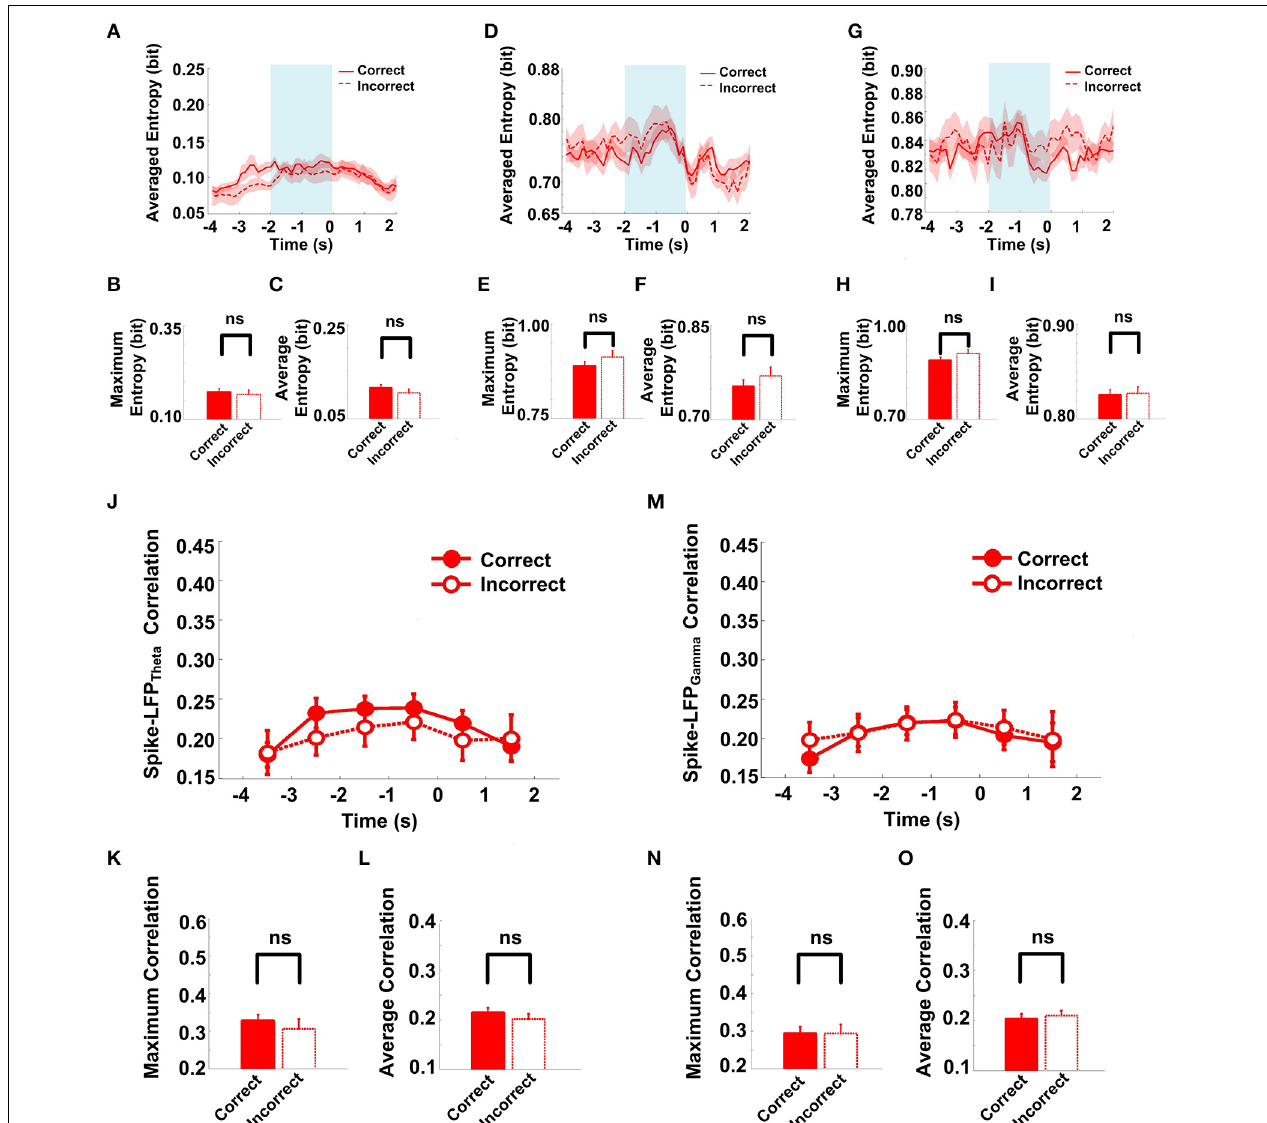
FIGURE 10 | Spike-LFP coordination in correct ( n = 35) and incorrect ( n = 21) trials in the A β group. (A) Averaged spikes entropy across correct (solid) and incorrect (dashed) trials. The shaded region indicates s.e.m. The light blue area indicates the period used for statistical analysis. Averaged entropy values were compared in this time window. (B) Peaks of spike entropy. (C) Averages of spike entropy. (D) Averaged entropy of LFP theta in correct and incorrect trials. (E) Peaks of LFP theta entropy. (F) Averages of LFP theta entropy. (G) Averaged entropy of